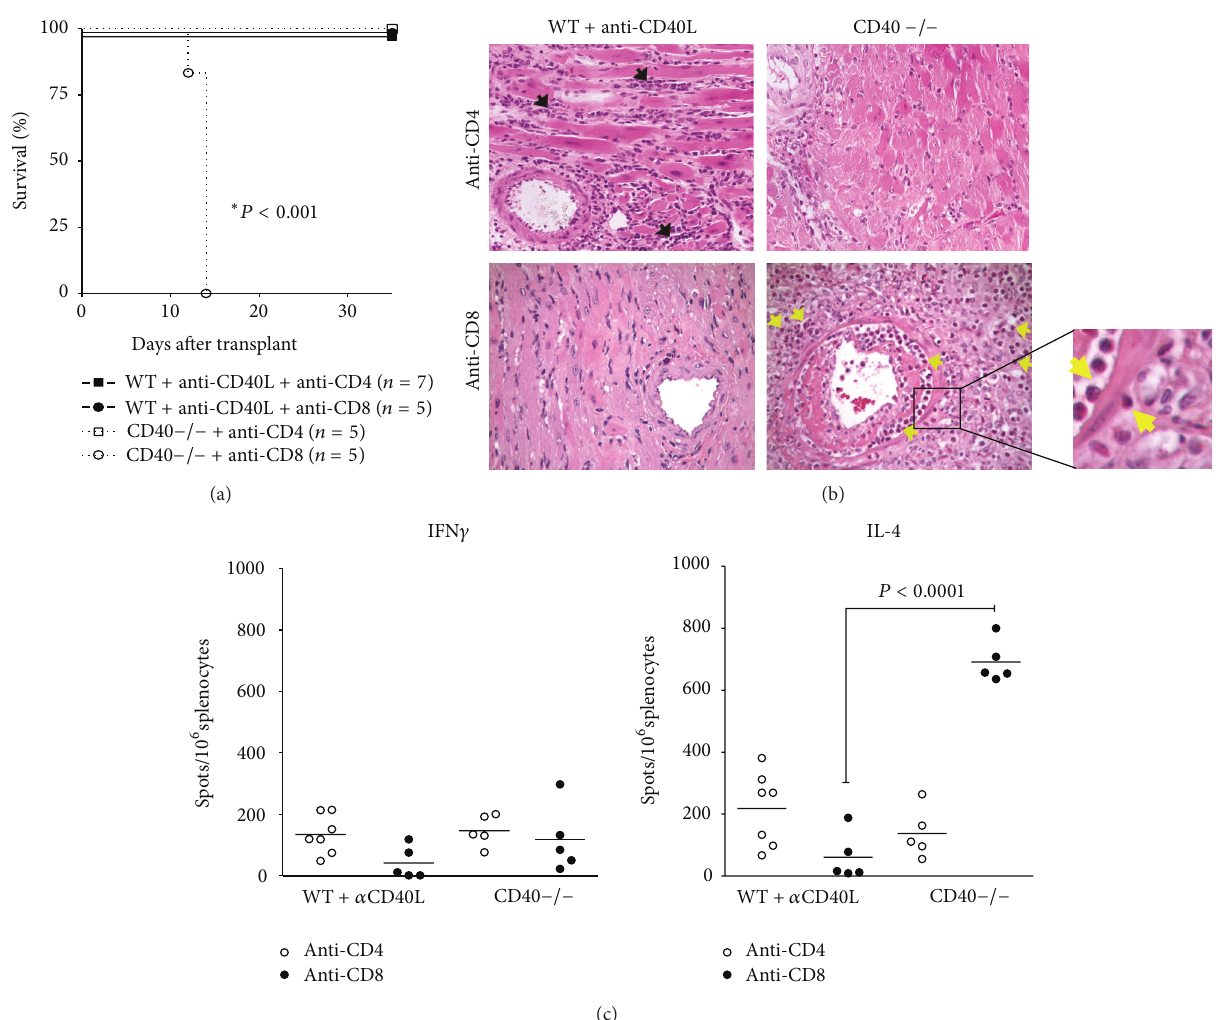
Figure 3: CD4+ T cells mediate GITR-stimulated graft rejection in CD40 − / − recipients. (a) Mann-Whitney survival plot of grafts was transplanted into WT+anti-CD40L (closed symbols) or CD40 − / − (open symbols) recipients depleted of either CD4+ (squares) or CD8+ (circles) T cells and treated with anti-GITR mAb on days − 1 and − 2 prior to transplant. Significance was determined via logrank analysis. (b) H&E staining ( × 200) of transplants recovered either at the day of rejection or at the termination of the experiment at day 35 after transplantation. Black arrows indicate mononuclear cellular infiltrate, and yellow arrows indicate eosinophils. The inset represents 1000x magnification of infiltrate observed in CD8-depleted CD40 − / − recipients. (c) Recipient splenocytes were harvested and processed at the time of rejection or at 35 days after transplant for ELISPOT assays, and primed, donor-reactive IFN- 𝛾 and IL-4 producing cells were quantified as the number of spots/10 6 total splenocytes. Significance was determined by a Student’s t -test with Welch’s correction.